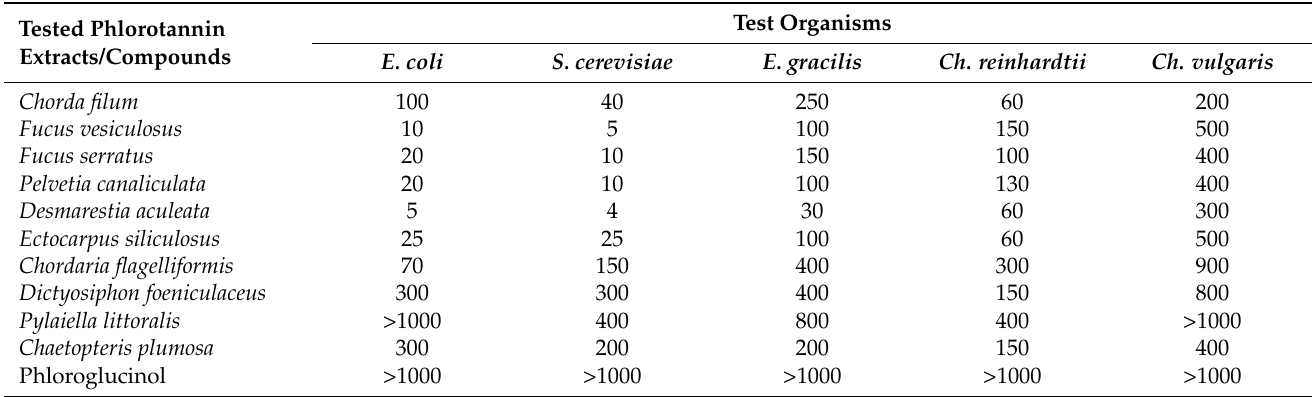
Table 1. Minimum inhibitory concentrations (MIC, µ g/mL) of phloroglucinol and phlorotannin- enriched extracts of ten brown algal species against the unicellular test organisms.